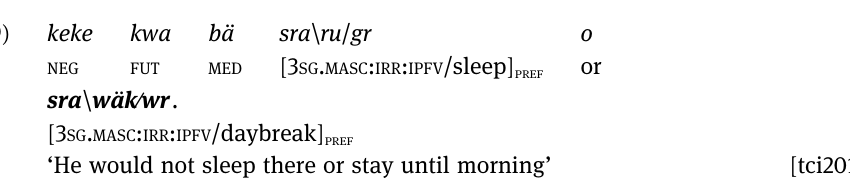
Table 4: Fluid pre fi xing verbs: positionals Lexeme Translation PREF PREF ( IO ) MID TRANS TRANS ( IO ) NMLZ brüzsi be submerged — — 21 5 — 2 fätfaksi be across sth. — — — — — — fethaksi be dipped in water — — 1 3 — — fi fthaksi be lying straight — — 1 3 — — krsi be blocked — — — 10 — 7 mgthksi be in the mouth a ∗ 4 — 22 2 5 migsi be hanging 18 1 8 13 4 3 moraksi be leaning — — 2 4 — — mosisi be gathered — — 9 16 1 — moyusi be shrunk — — — — — — mreznsi be straight — — — 1 — — mtheksi be lifted up ∗ — 4 16 — 1 myuknsi be twisted — — — 2 — 1 nänzüthzsi be covered with soil 1 — — 10 — — ra fi gsi be on top of sth. 2 — 7 26 2 — rakthksi be on top of sth. — — — 4 1 — rfakusi be sprinkled — — 2 2 — — rfuthraksi be piled up ∗ — 1 — — — rgsi be wearing clothes ∗ 6 15 — — 1 rinaksi be poured into 1 — — 10 5 1 rmiththraksi be joined together — — — 3 — — rmnzüfaksi be side by side —